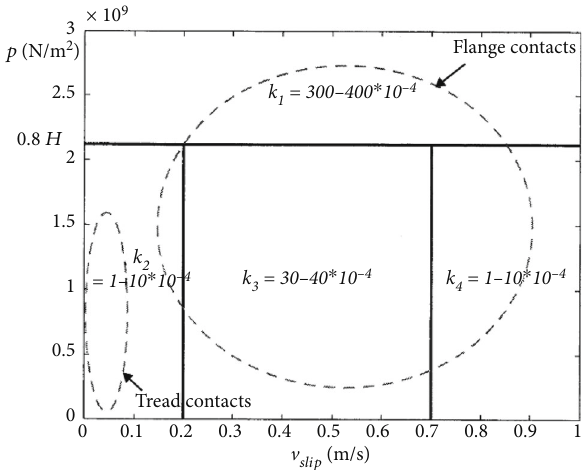
Figure 5: Wear map for the wear coe ffi cient k conditions